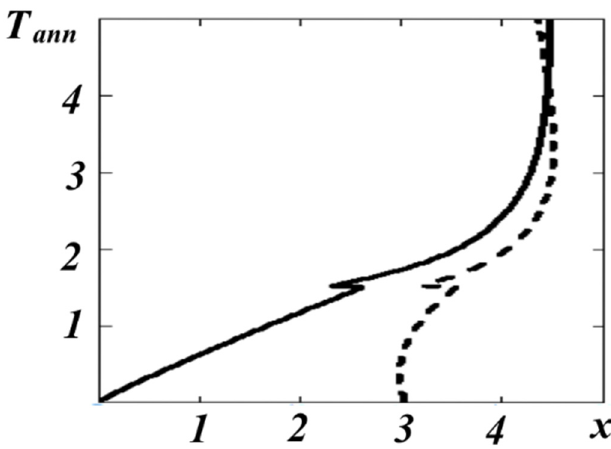
Figure 8. Dependence 𝑥(𝑇 (cid:3028)(cid:3041)(cid:3041) ) before HPT (solid line) and after HPT (dotted